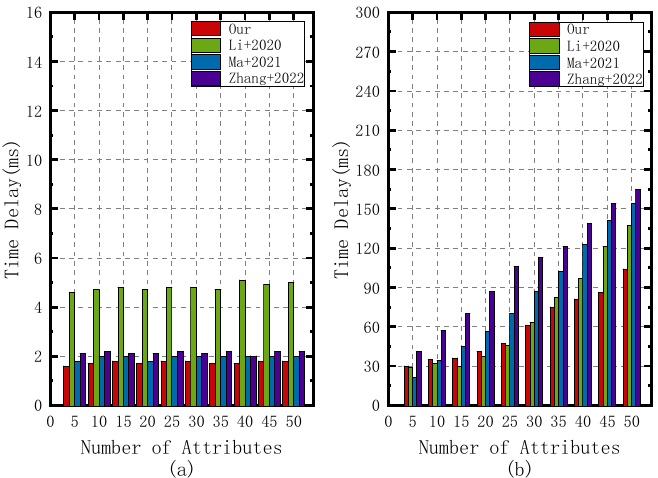
Figure 7. ( a ) Cost of user decryption ( b ) Cost of RSU decryption [23–25].